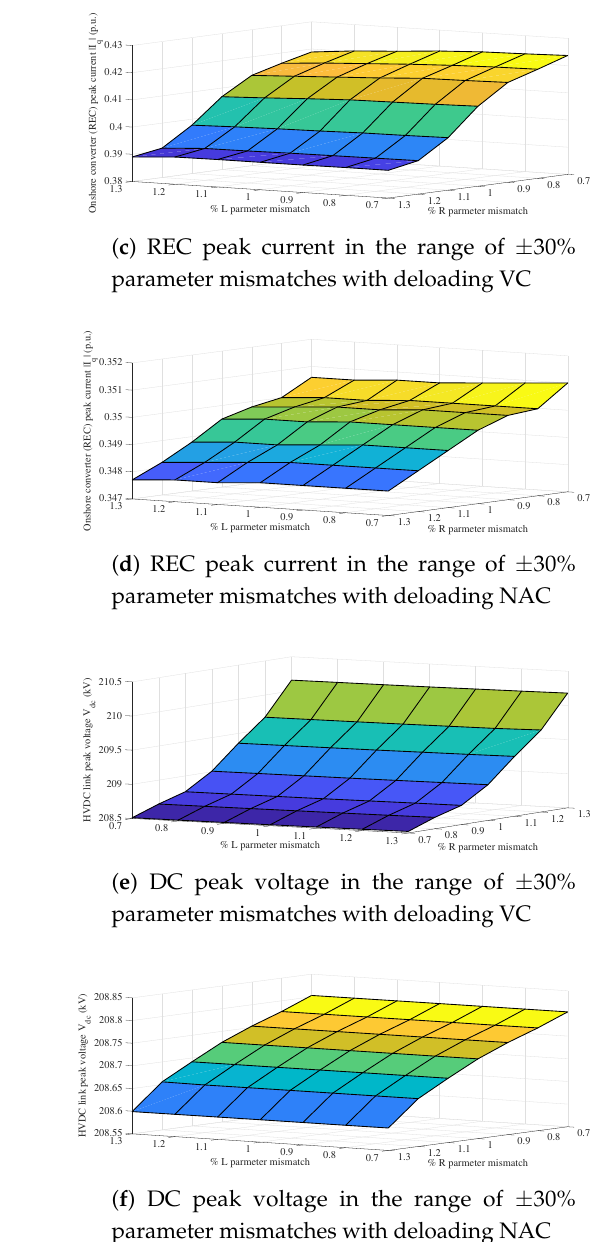
Figure 10. System responses obtained with 0.3 s duration of 30% voltage sag at onshore AC grid with grid parameter